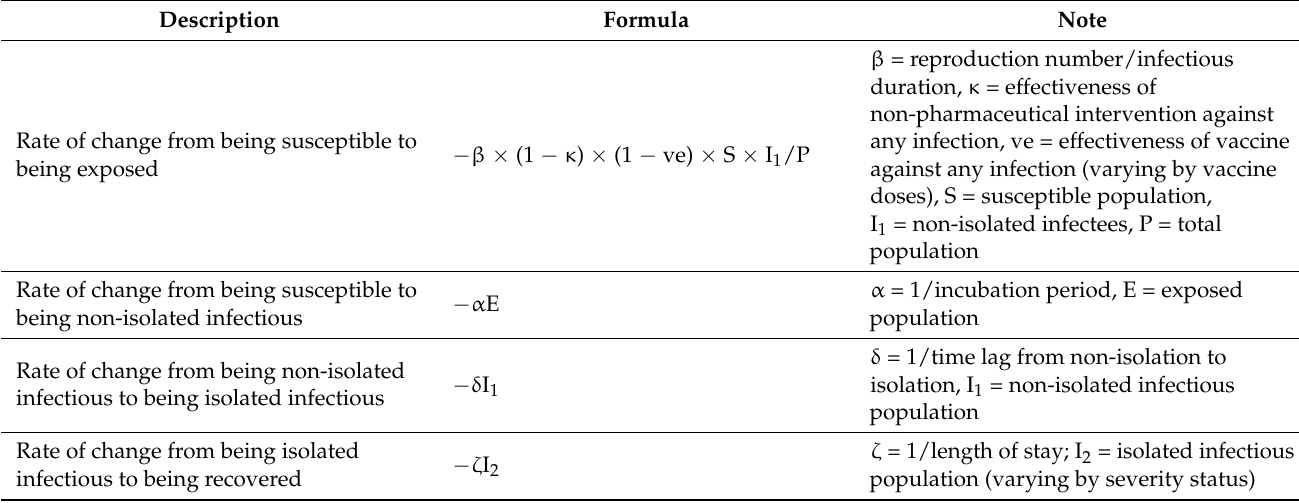
Table 2. The essential formula of the model.